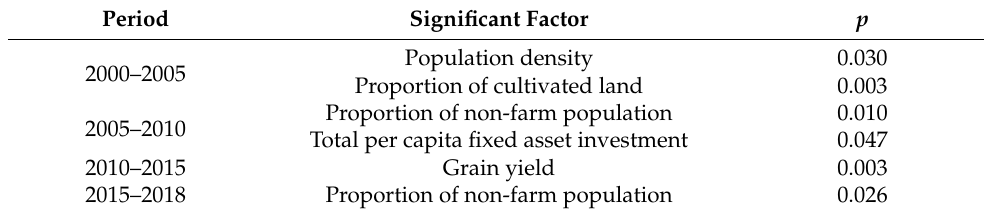
Table 4. Major driving forces in different periods.